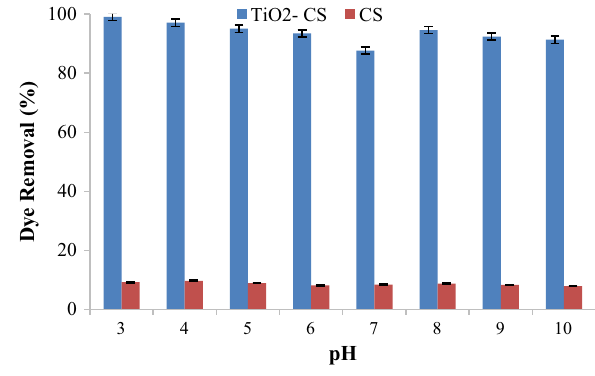
Fig. 6 Effect of pH on the photocatalytic removal rate of RB5 azo dye (25 °C, 300 rpm)